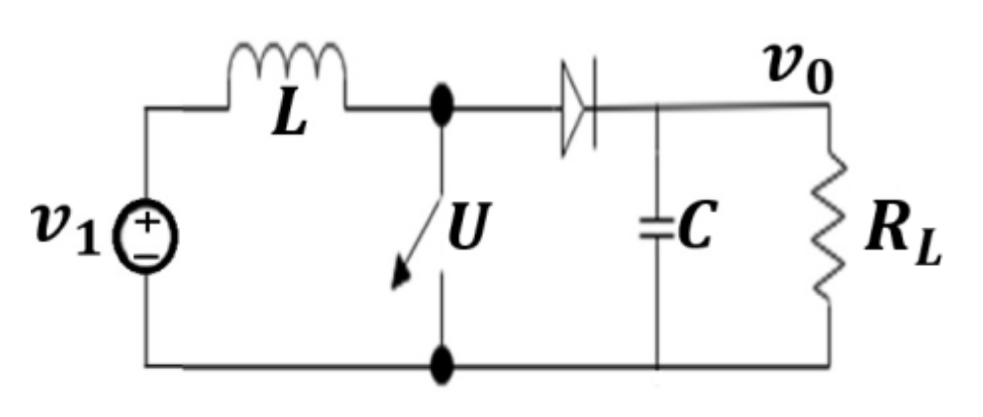
Figure 1. Diagram of a boost